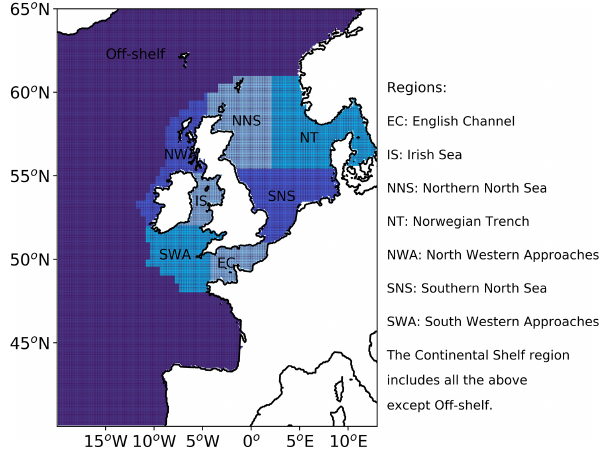
Figure 3. Map showing the subregions over which statistics are computed.